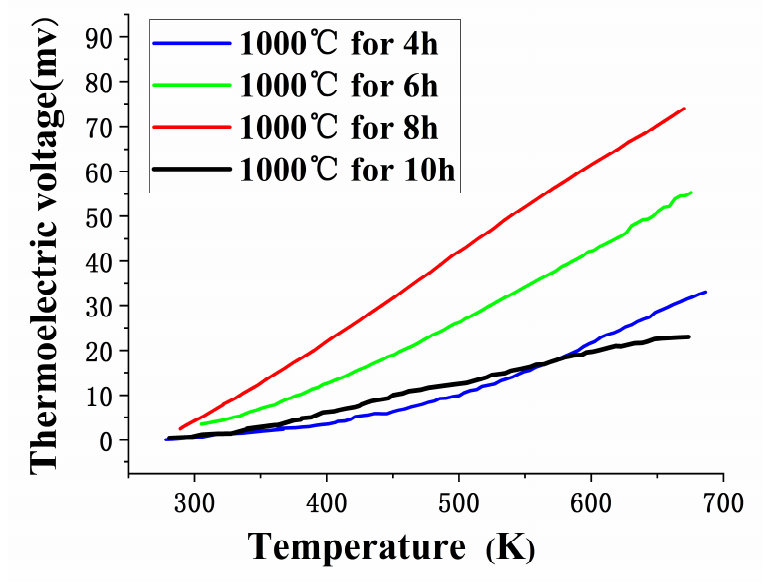
Figure 11. The SEM of In 2 O 3 films under di ff erent annealing processes. ( A : 1000 ◦ C in air for 4 h. B : 1000 ◦ C in air for 6 h. C : 1000 ◦ C in air for 8 h. D : 1000 ◦ C in air for 10 h.).